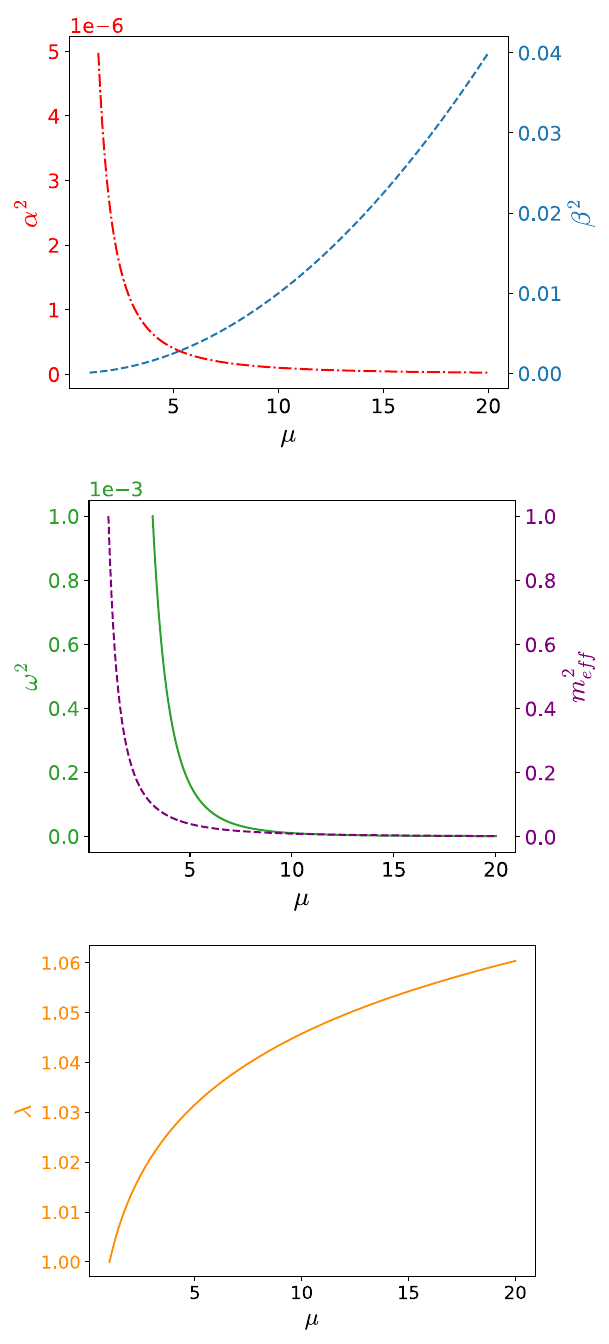
Fig. 1 Numerical solutions for the running of all the parameters of the theory,choosingasinitialconditions v 1 = an energy μ 0 = 1 (all the quantities are measured in the corresponding powers of eV)